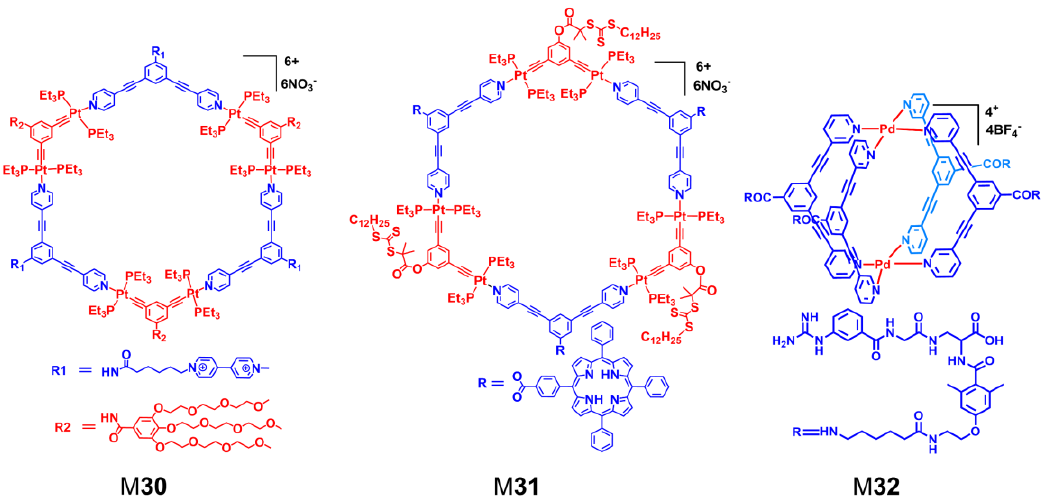
Figure 6. The structures of M 30 − M 32 . Adapted with permission from references [18,97,98]. Copy- right 2018 National Academy of Sciences (USA); 2018 American Chemical Society; 2019 Royal Society of Chemistry.